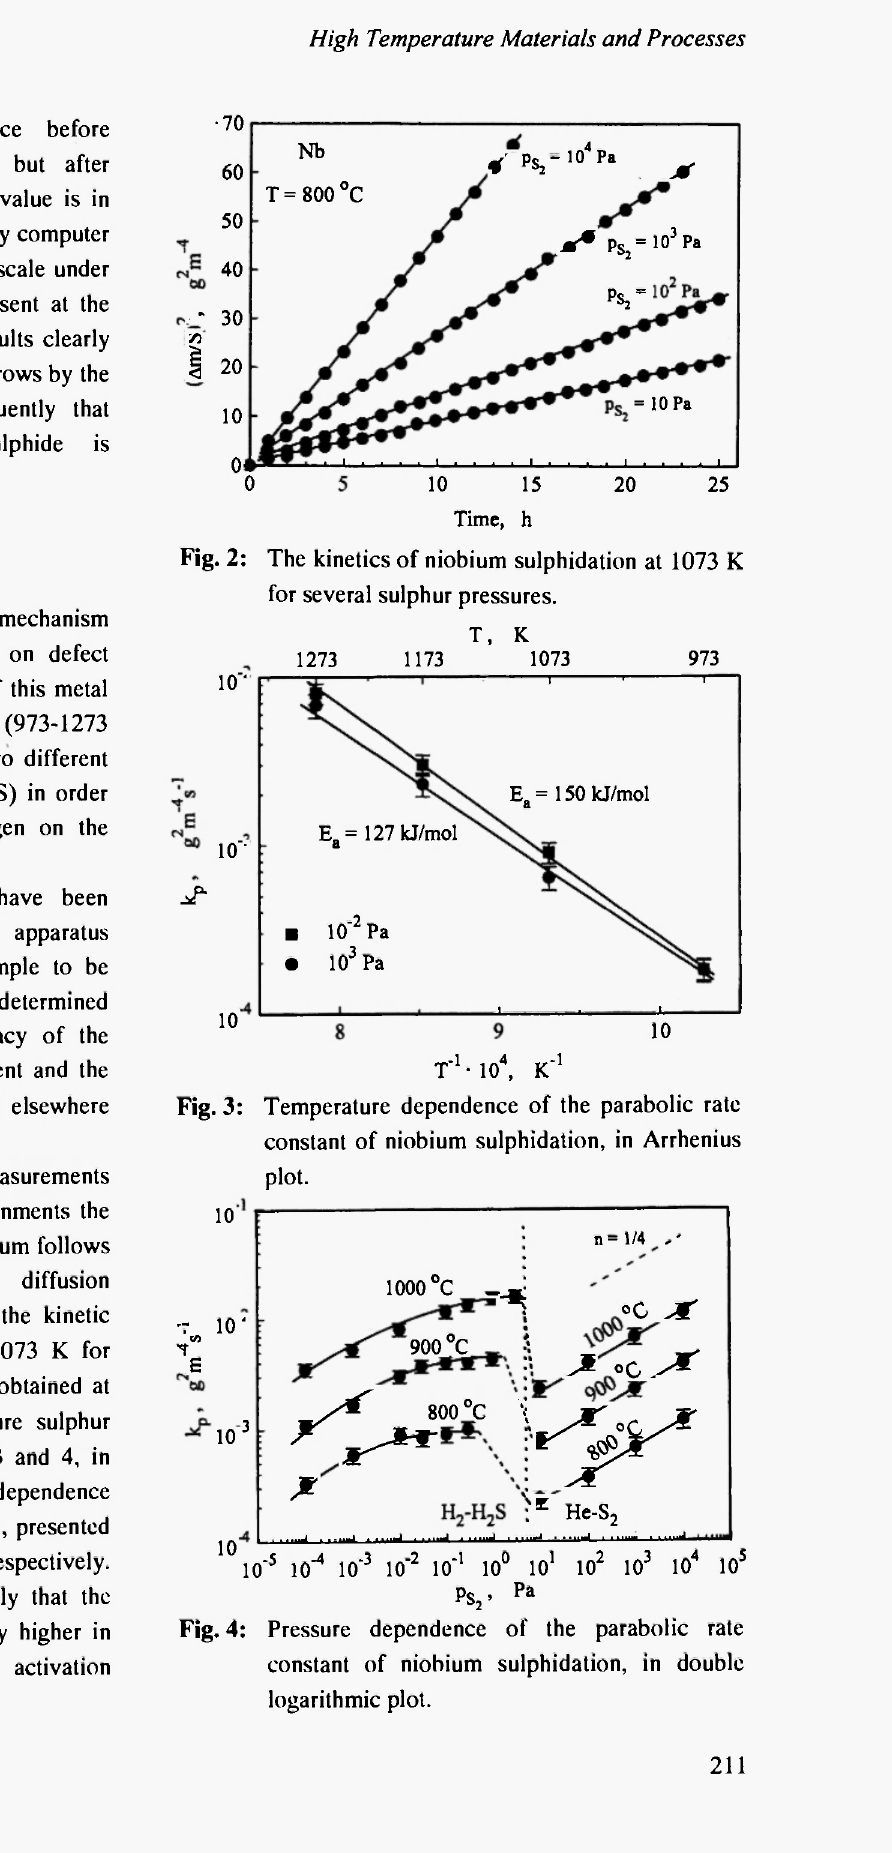
Fig. 4: Pressure dependence of the parabolic rate constant of niobium sulphidation, in double logarithmic